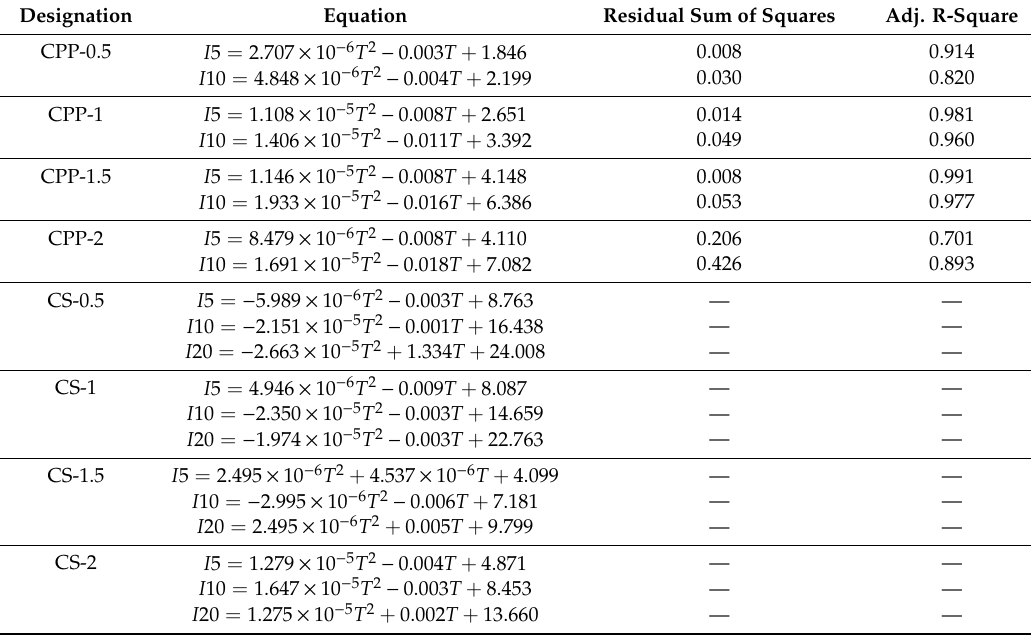
Figure 9. Temperature–toughness indexes fitted curves of SF-reinforced UHPC ( a ) I5, ( b ) I10, ( c ) I20. It can be concluded that the nonlinear relations agree very well with the test results. Nonlinear regression leads to the relationships of the temperature–toughness indexes listed in Table 6. Table 6. Temperature–toughness index relationship of SF/PPF-reinforced UHPC.